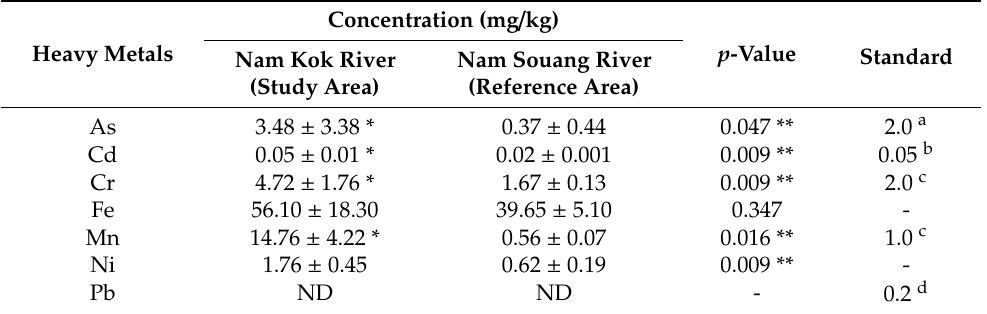
Table 5. The heavy metal and metalloid concentrations in O. vittatus samples (n = 10) from the Nam Kok river near the Sepon gold-copper mine as the study area and the Nam Souang river as the reference area.